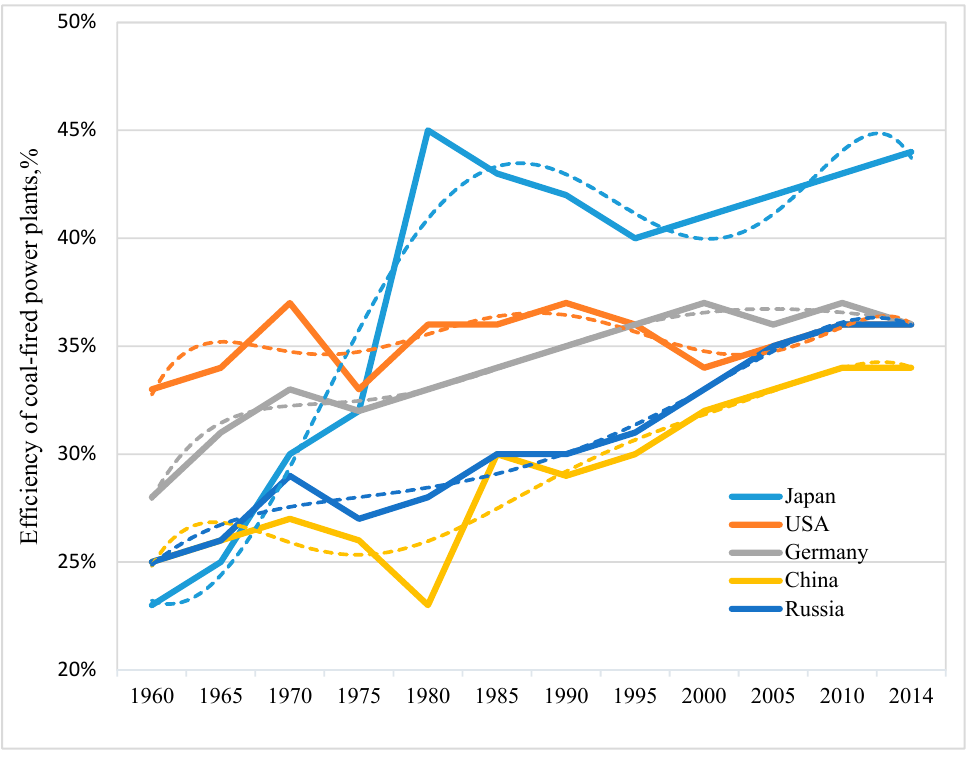
Figure 1. Development of coal thermal power plants (TPPs) in countries with the most developed energy sector.